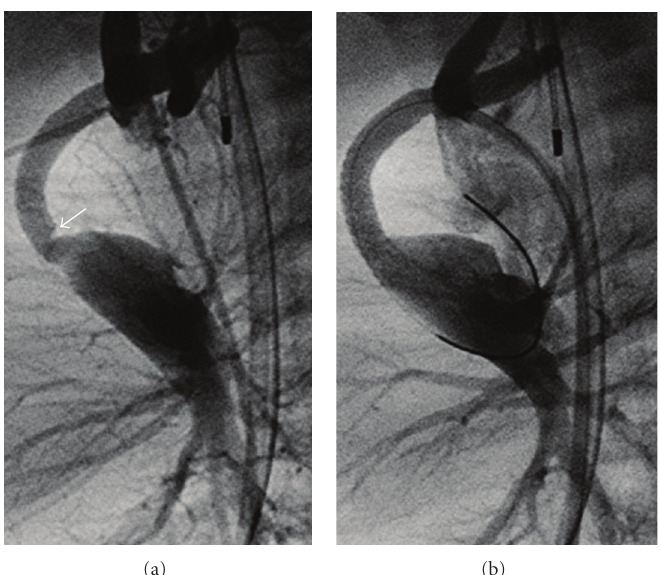
Figure 3: (a) angiographic (lateral) view during cardiac catheterization demonstrating shunt narrowing. (b) angiographic (lateral) view during cardiac catheterization demonstrating shunt poststent